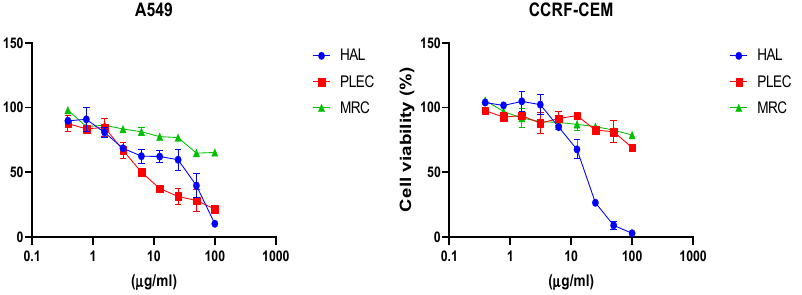
Figure 2. Effects of HAL, PLEC and MRC on A549 and CCRF-CEM cell viability, as determined by the MTT assay after 24 h. Values represent the means ± SD as a percent (%) of control. Values on the X -axis are shown as log10.